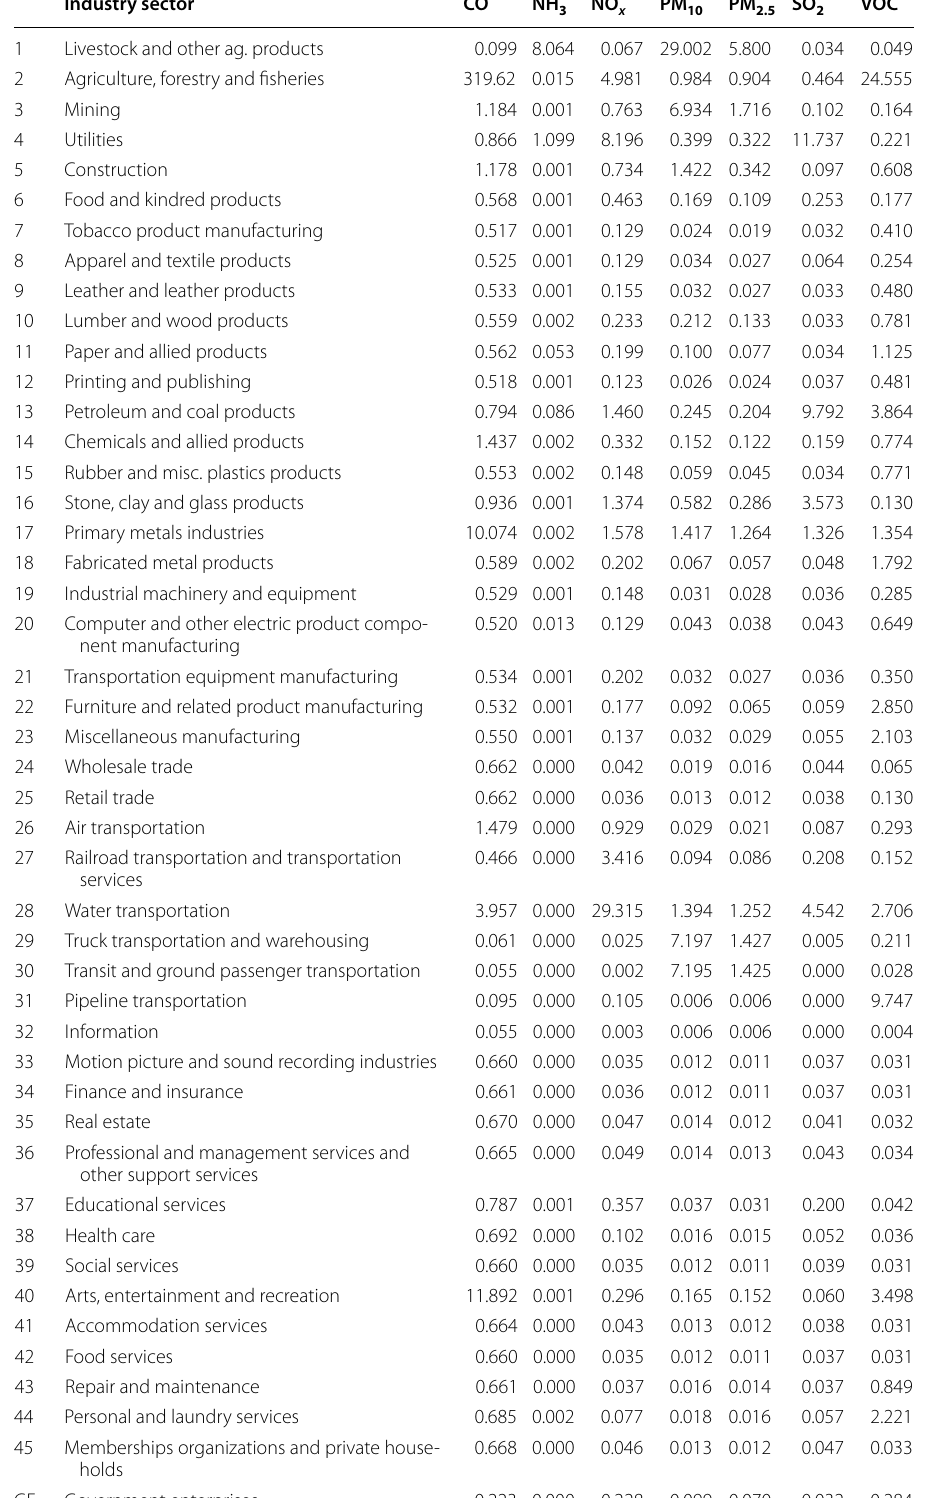
Table 2 1999 fixed emissions intensities (EMI) in Chicago